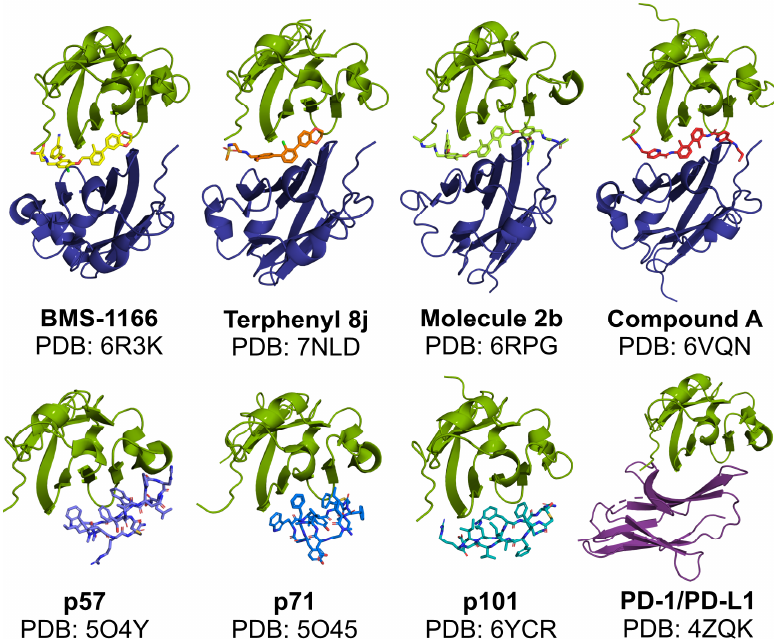
Figure 3. Modes of in vitro binding of PD-L1-targeted molecules to PD-L1. Like therapeutic antibodies, macrocyclic peptides bind and block PD-L1 at a similar surface as recognized by the PD-1 protein (the bottom panel). In contrast, in the presence of biphenyl molecules, a formation of PD-L1 dimers is favored, with a single molecule bound within the interface of the two PD-L1 protomers (the upper panel). Green— A PD-L1 protomer; dark blue— B PD-L1 protomer; purple—PD-1; other colors: small molecules and macrocyclic peptides.